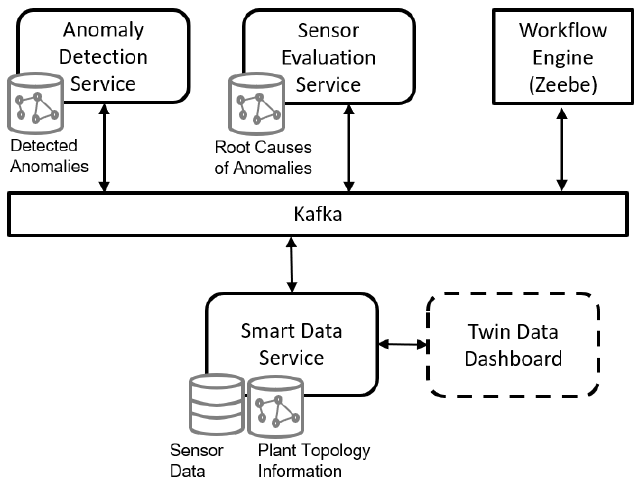
Figure 2. Overview about implemented services for sensor data